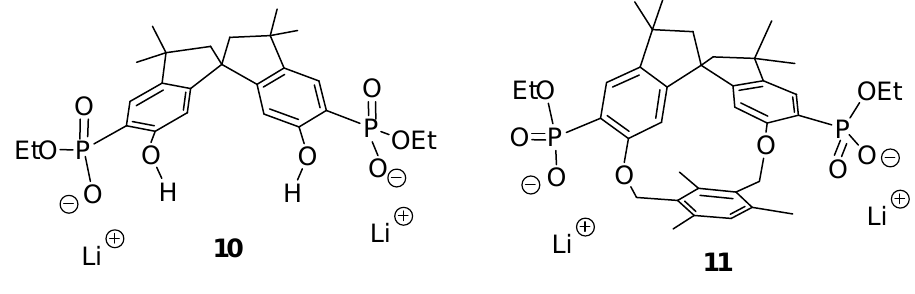
- whereas macrocycle 11 has C 2